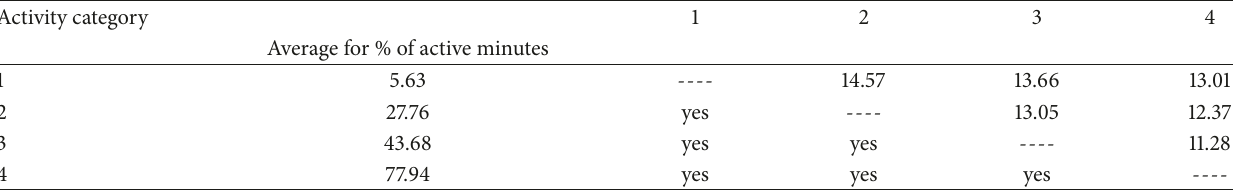
Table 2: ANOVA for percentages of active minutes per event distributed according to clinically defined activity categories. The decision, whether a minute was active or not, was based on a SVM cut-off calculation. The table shows the critical average differences between group pairs (right up) and the statistical significance evaluation ( 𝑝 < 0.05 ) left down.